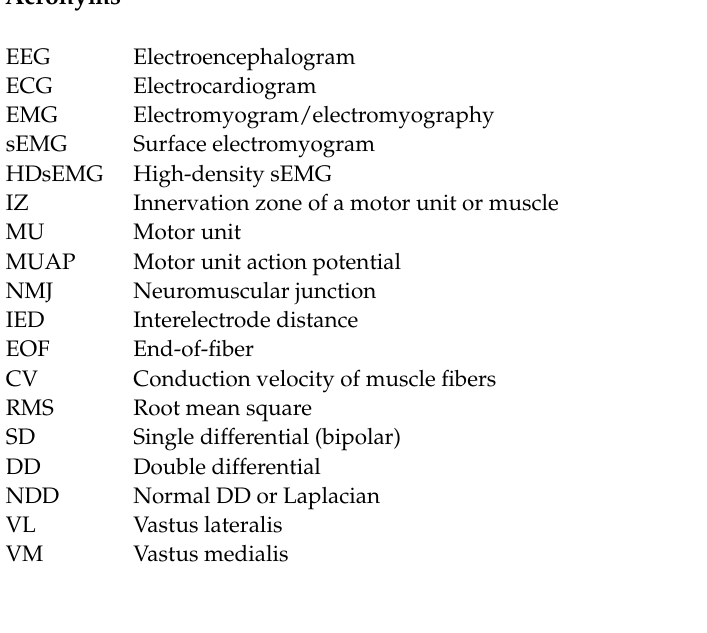
Figure 7: Sup4, Figure 11: Sup5, Figure 12: Sup6, Figure 13: Sup7, Figure 14: Sup8, Figure 15: Sup9, Figure 18: Sup10, Figure 20: